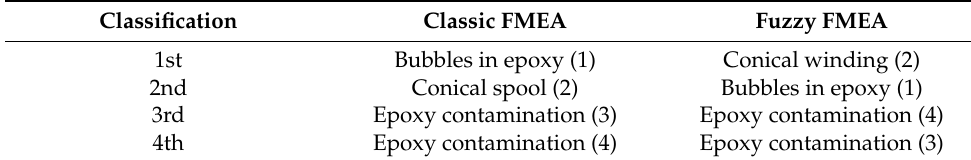
Table 7. Prioritization obtained by classic FMEA and fuzzy FMEA.